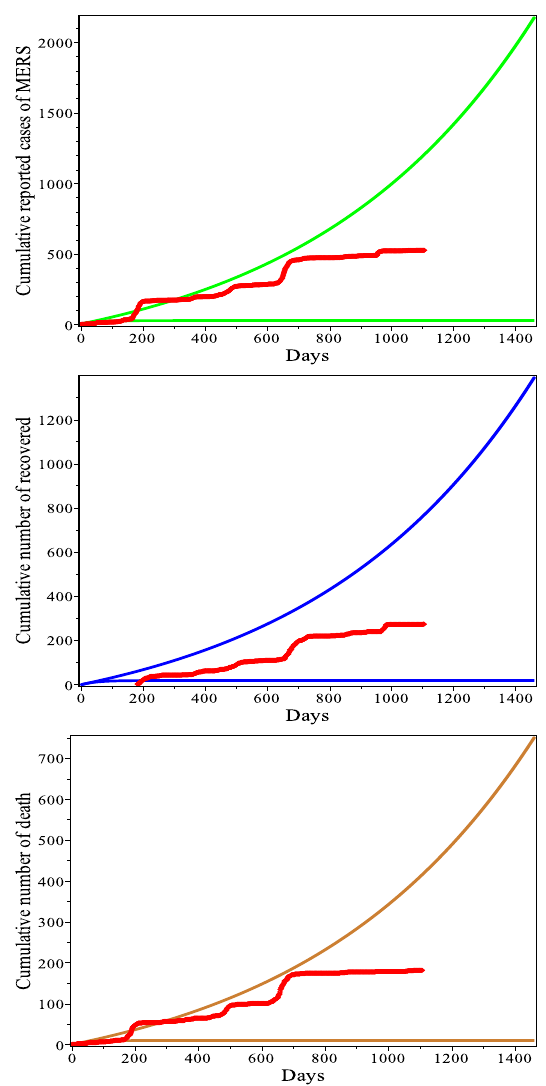
Fig. 7: Variations in the transmission reduction factor (cid:15) E lead to variations in the cumulative reported cases of MERS (T), cumulative number of recovered (M), and cumulative number of death (B), as ω varies randomly in Ω (cid:15) , so that (cid:15) E varies E in [0 . 01 , 0 . 318]